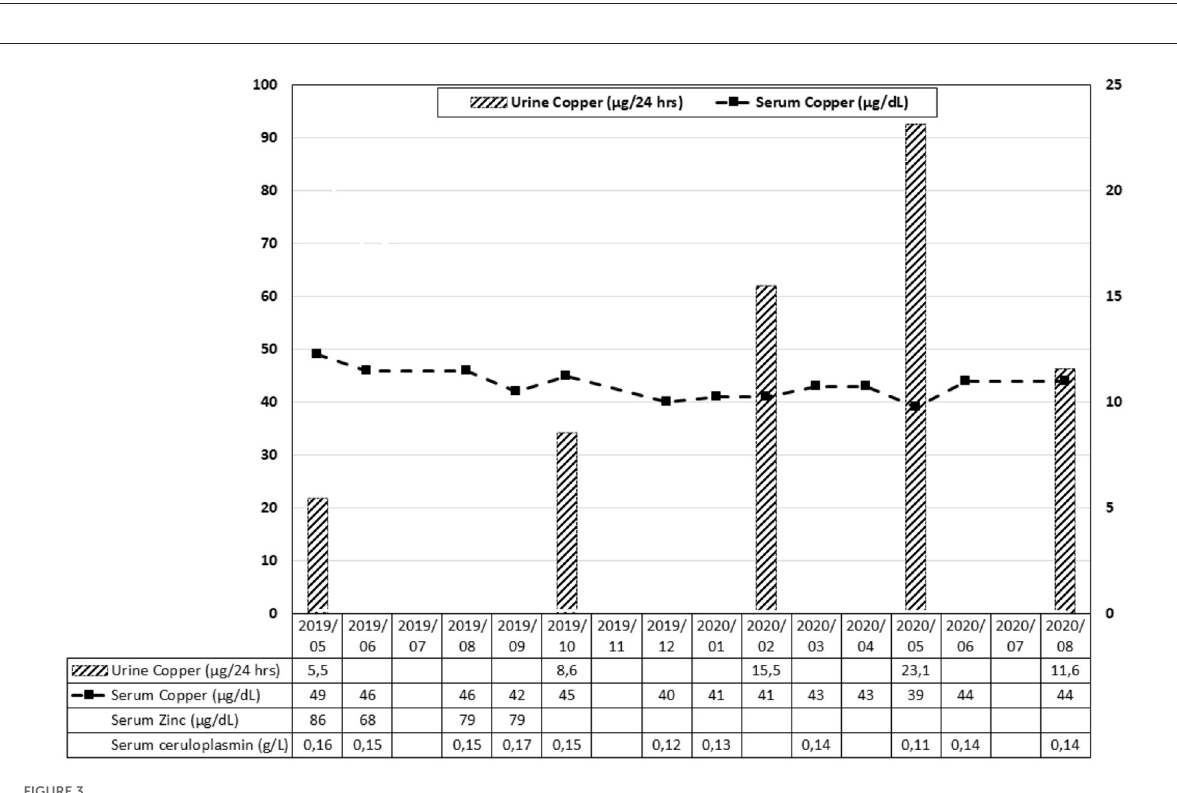
dose, duration, route, and form of copper